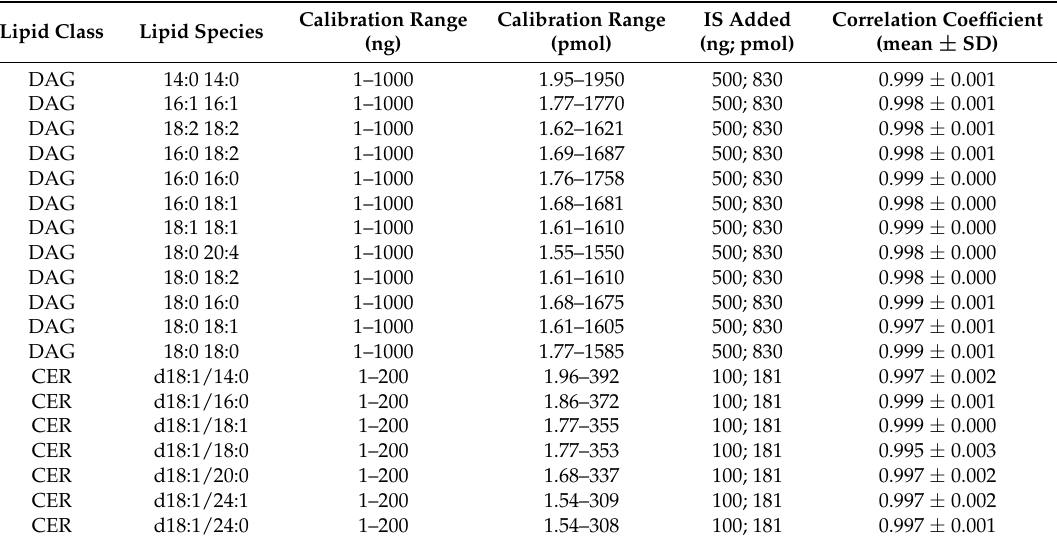
Table 2. Calibration data of the indicated lipid species.